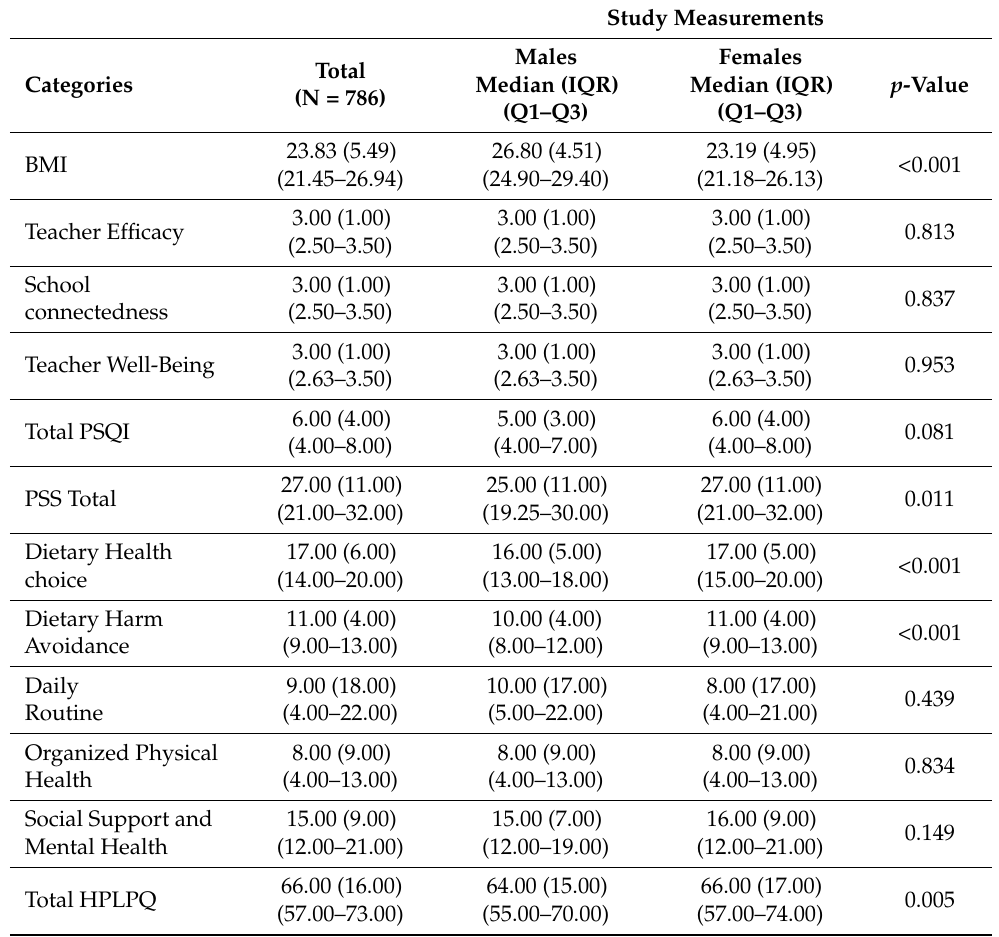
Table 2. The sample’s study